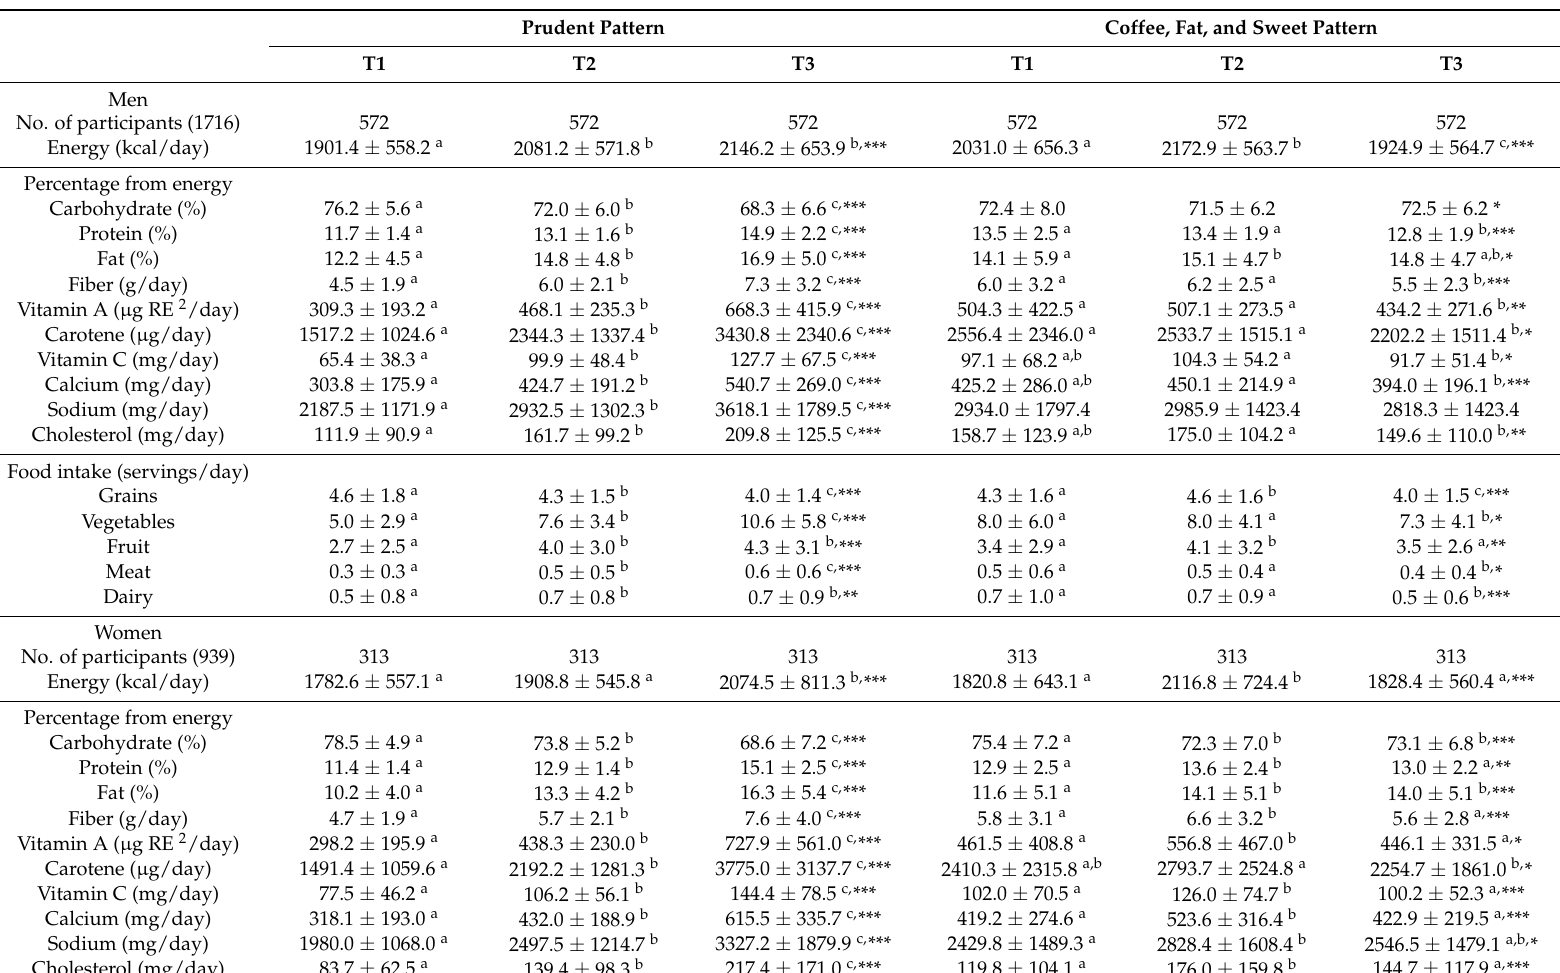
Table 4. Nutrient and food intakes of Korean in low high-density lipoprotein cholesterolemia analysis according to the tertile (T) categories of dietary pattern scores ( n = 2655) 1